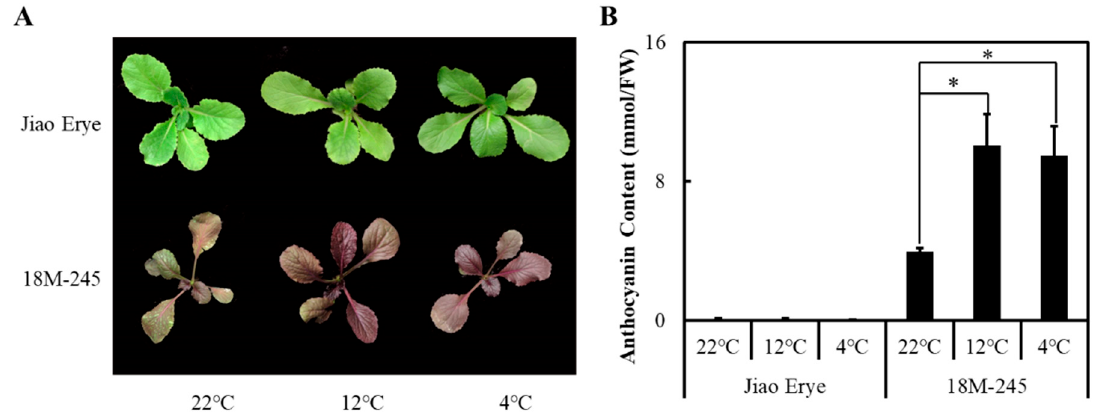
Figure 2. Anthocyanin accumulation in 18M-245 under low-temperature conditions. Phenotypes of Jiao Erye and 8M-245 grown at 22, 12 and 4 °C for 4 weeks, respectively ( A ). Leaf anthocyanin contents of four-week-old Jiao Erye and 18M-245 leaves at each temperature ( B ). Data are shown as the mean value ± SE. Asterisks indicate significant differences; Student’s t -test (* p < 0.05).